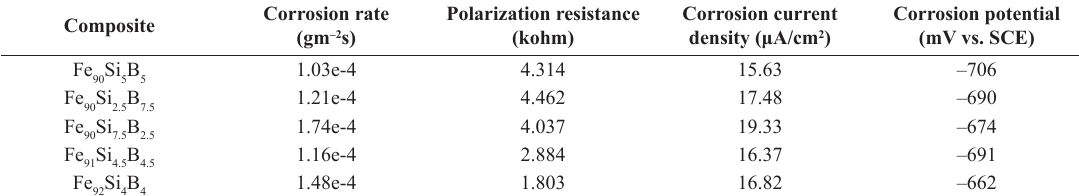
Si B ,Fe Si B , Fe Si B , Fe Si Si 90 2.5 7.5 90 5 5 90 7.5 2.5 91 4.5 4.5